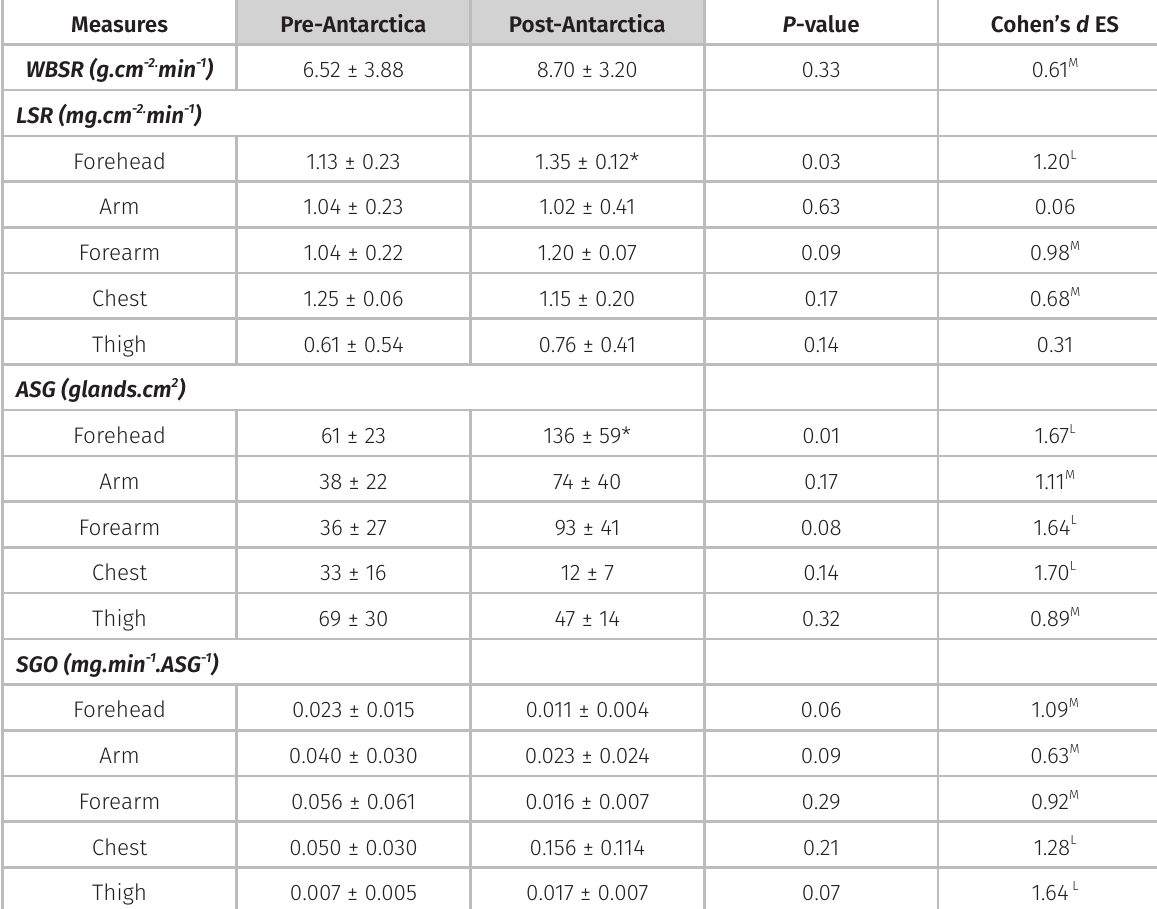
Table III. Thermoregulatory variables during the exercise heat stress protocol in the pre-Antarctica and post- Antarctica